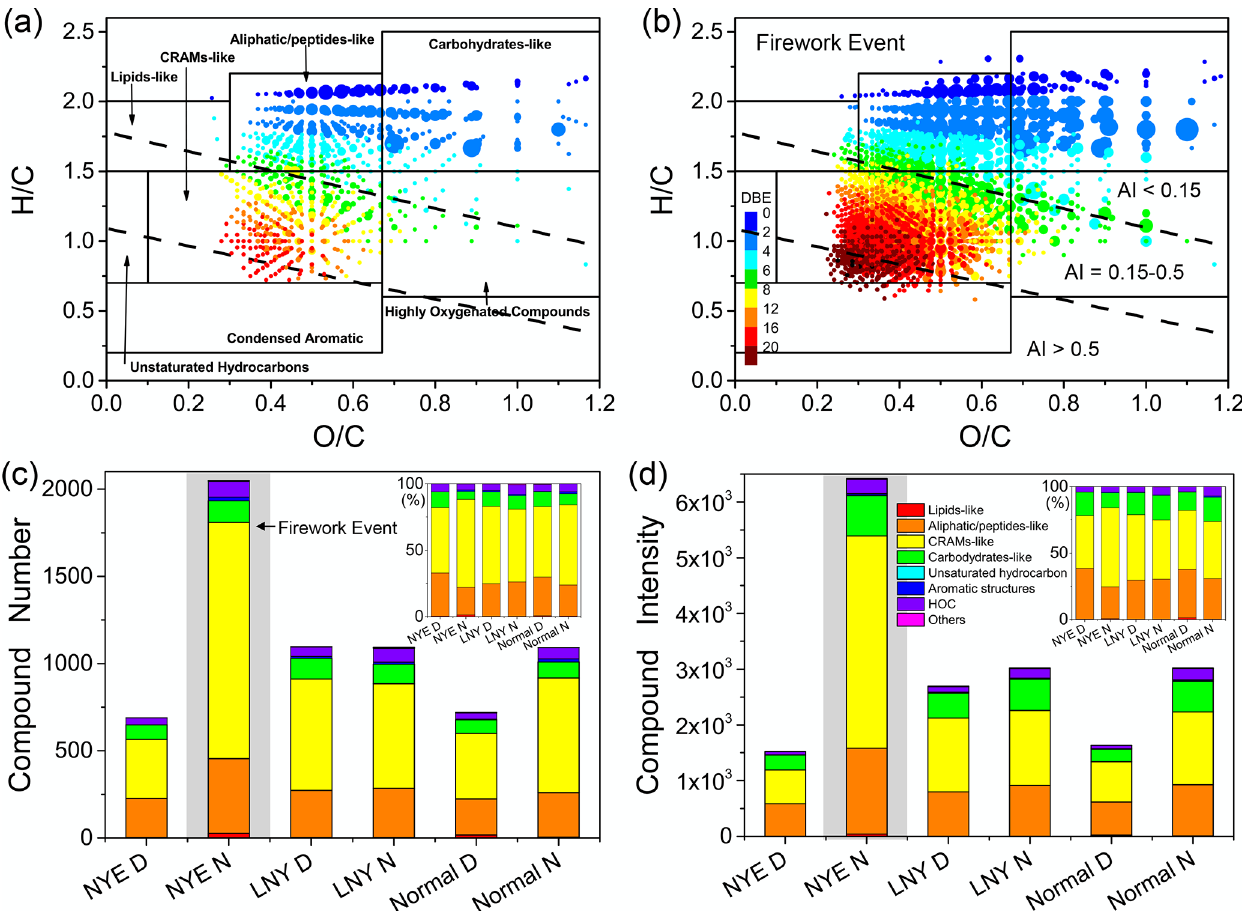
Figure 3. Typical Van Krevelen symbols for (a) NYE D and (b) NYE N. Dotted black lines show various AI value ranges, and black lines denote class identification. The size of the plots represents the relative intensities of nitrooxy OSs on a logarithmic scale. The colored bars of (a) and (b) reflect the DBE values. Bar diagrams of (c) and (d) show the number and intensity contribution of major classes in different samples,